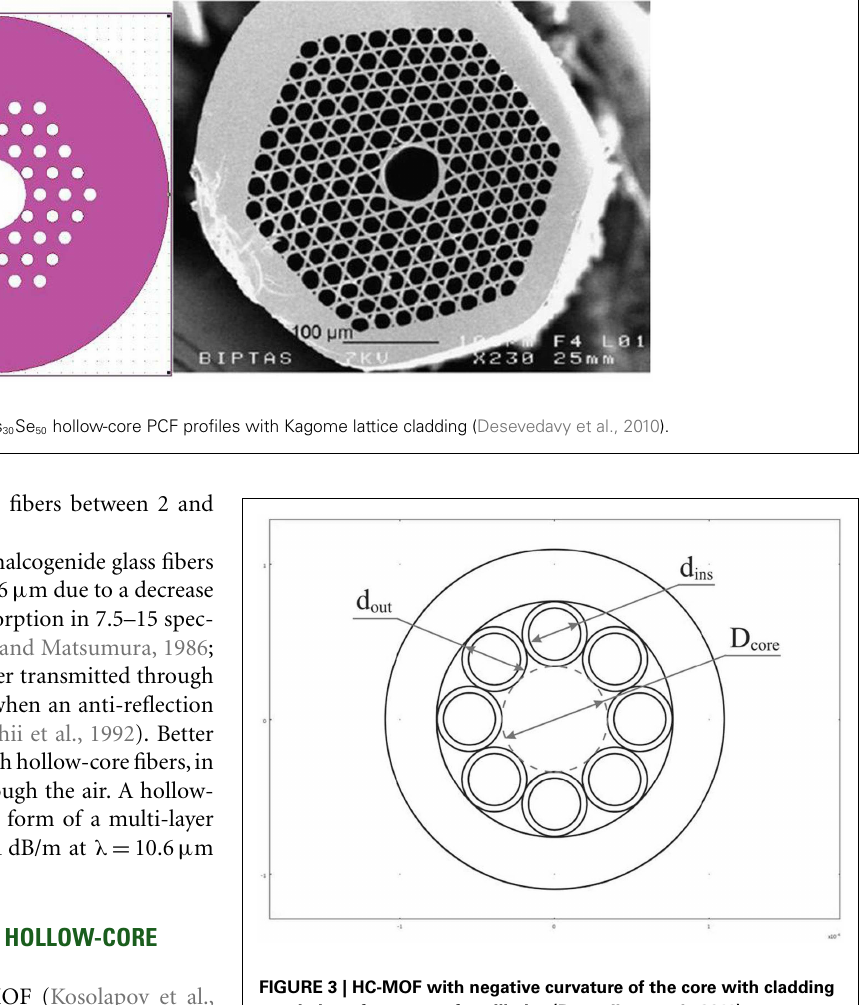
ratio of the inner and outer diameters of the capillaries of